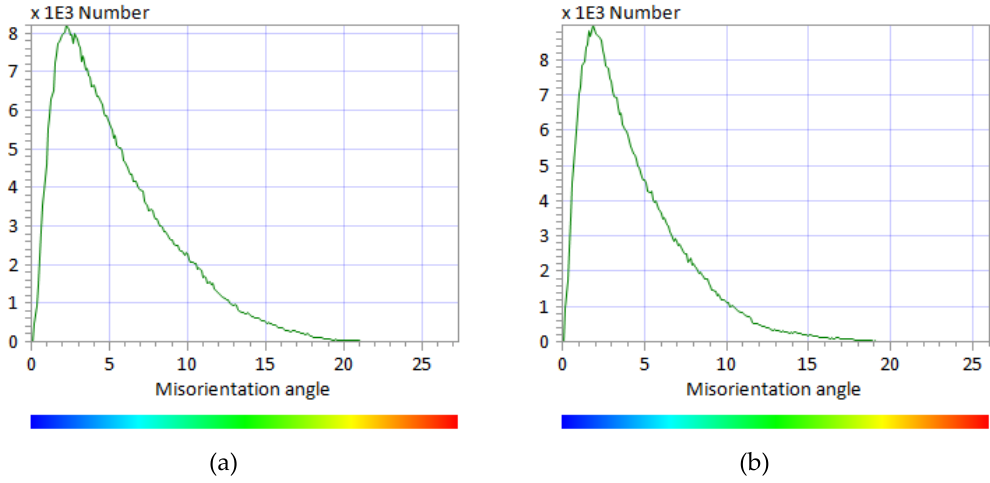
Figure 12. GAM changes on IC CGHAZ area during the four days of monitoring: ( a ) first day of monitoring and ( b ) fourth day of monitoring.